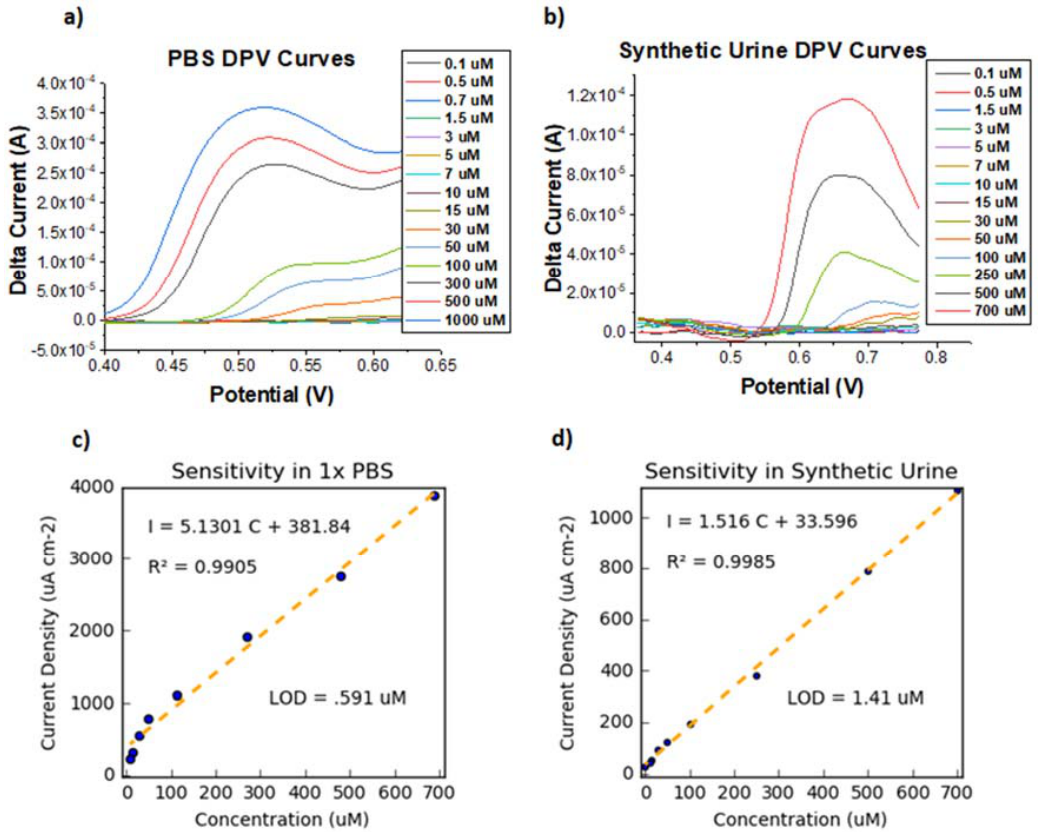
Figure 4. DPV curves (background subtracted) and calibration plots based on DPV data showing iodide sensitivity in 1X PBS ( a , c ) and synthetic urine ( b , d ). The regression equation, correlation coefficient, and estimated LOD are also shown on the plot.